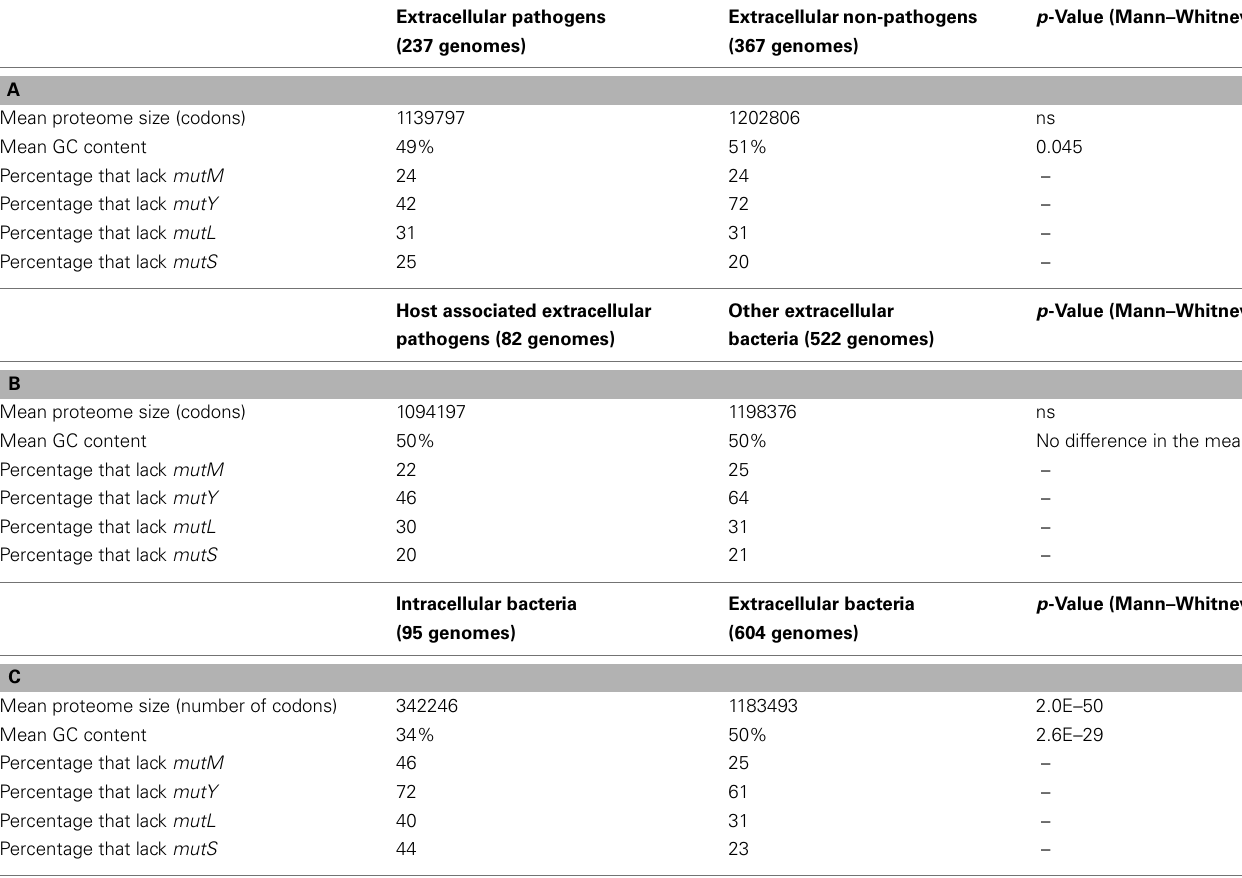
Table 3 | Gene contents of pathogenic and non-pathogenic extracellular bacteria 604 extracellular bacterial genomes were examined for their average proteome sizes, average GC contents, and gene